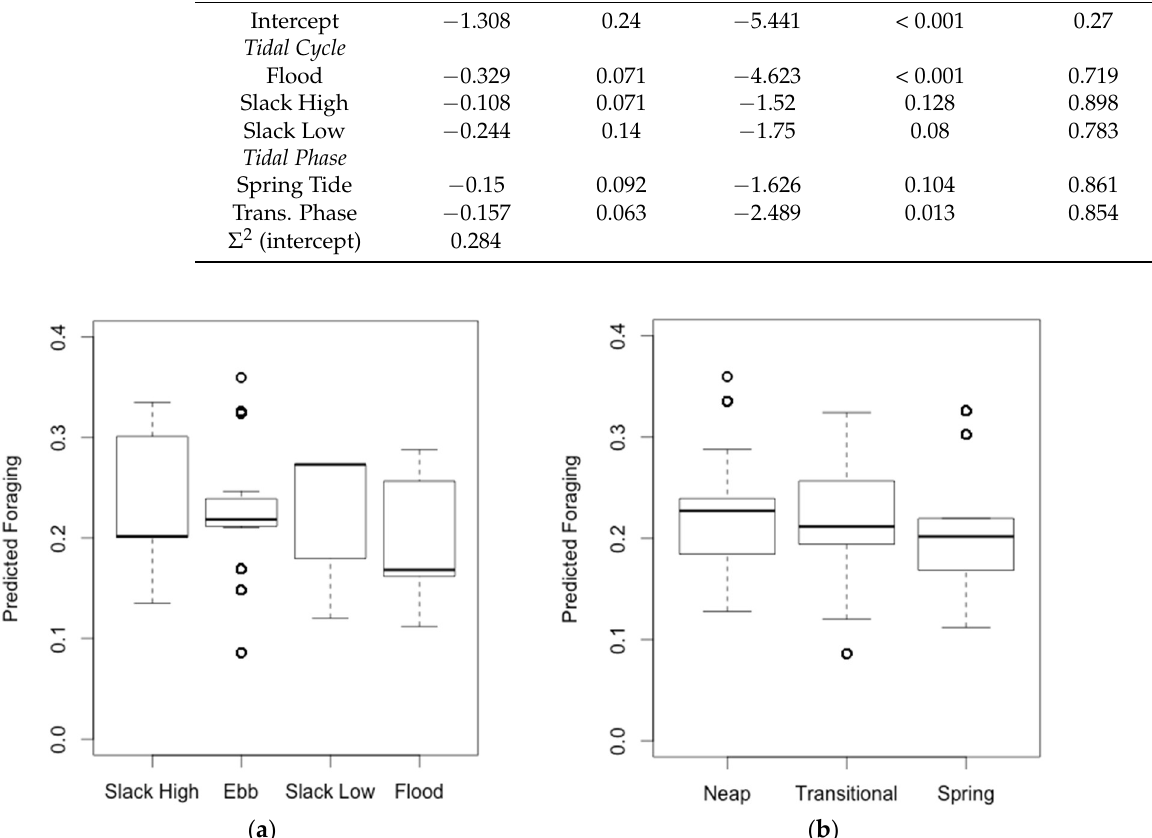
Figure 8. Predicted foraging at Shannon Airport for the explanatory variables included in the best model: ( a ) Tidal Cycle and ( b ) Tidal Phase.